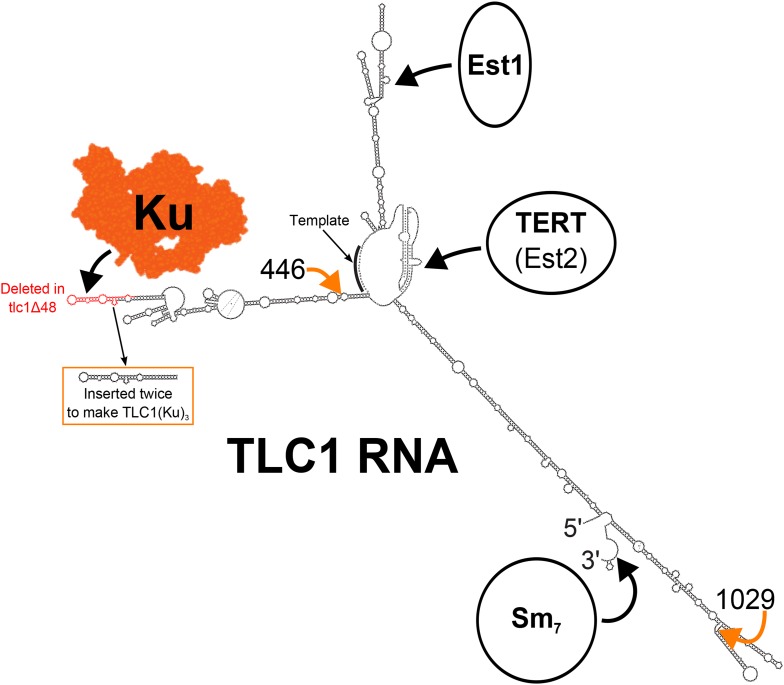
Secondary structure model of yeast telomerase RNA.The 48 nucleotides deleted in the tlc1Δ48 allele are highlighted in red. The 74-nucleotide hairpin shown in the orange box was inserted at positions 446 and 1029 (indicated by the orange arrows) to create TLC1(Ku)3. The TLC1 secondary structure shown is based on previously published models of the core (Niederer and Zappulla, 2015) and of the arms (Dandjinou et al., 2004; Zappulla and Cech, 2004), while the Ku crystal structure shown is that of the human Ku70/80 complex (Walker et al., 2001).